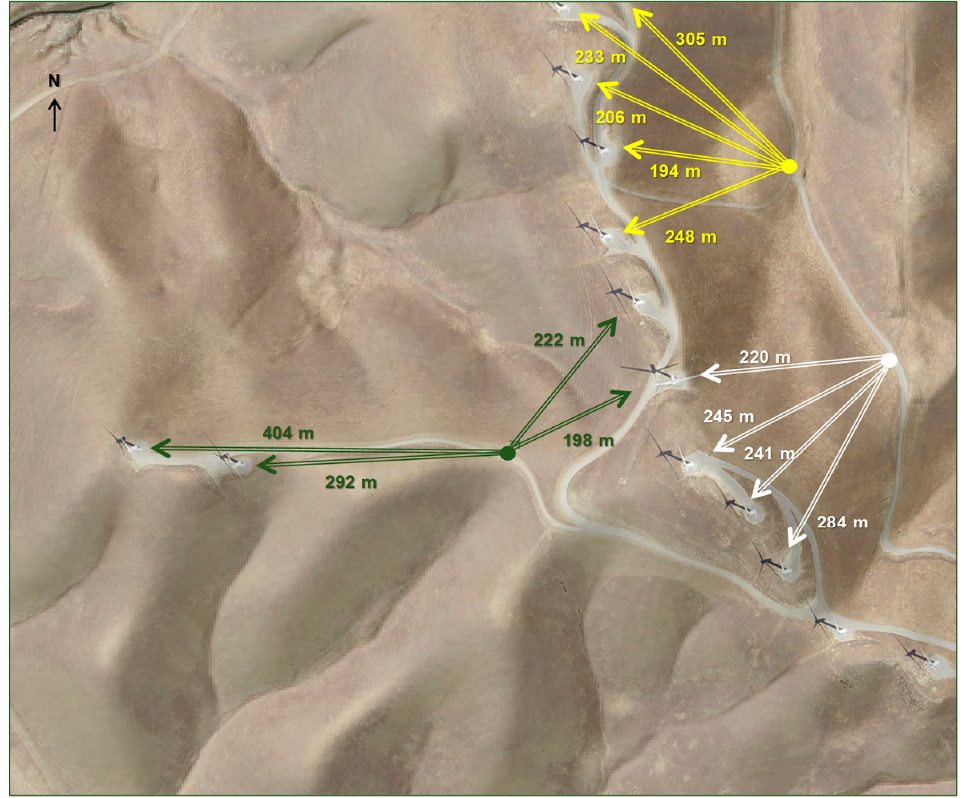
Figure 1. Buena Vista wind turbines viewed (arrows) from 3 survey stations (yellow, white and green circles) during nocturnal surveys in Fall 2017.